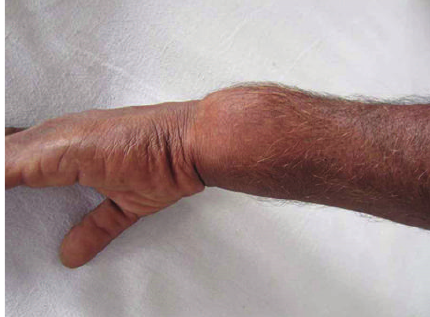
Figure 2: Preoperative clinical photograph.